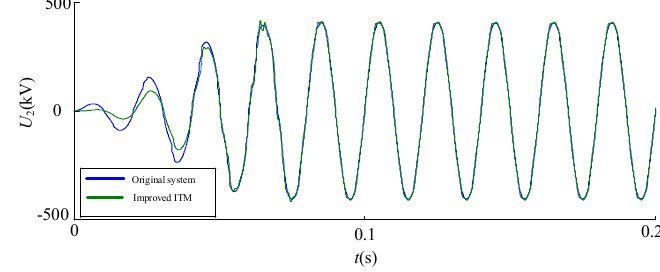
Figure 8. Waveform of the voltage for the improved ITM interface model.